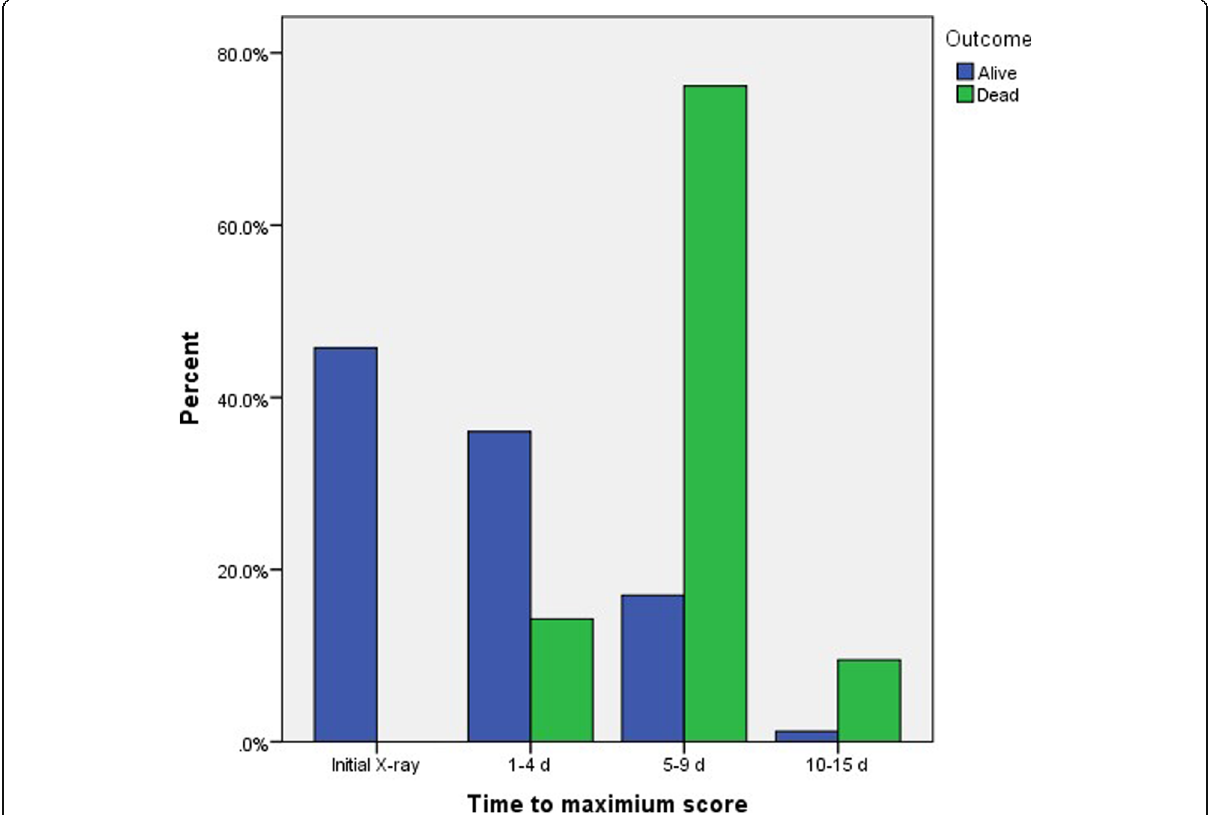
Fig. 14 Percentage distribution of time to maximum score and